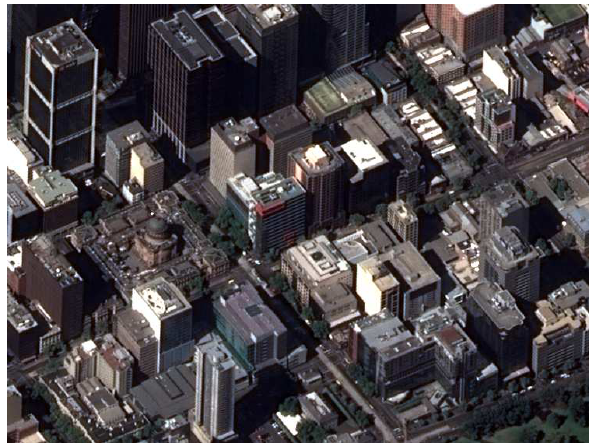
Figure 1 : Pleiades-HR image of Melbourne